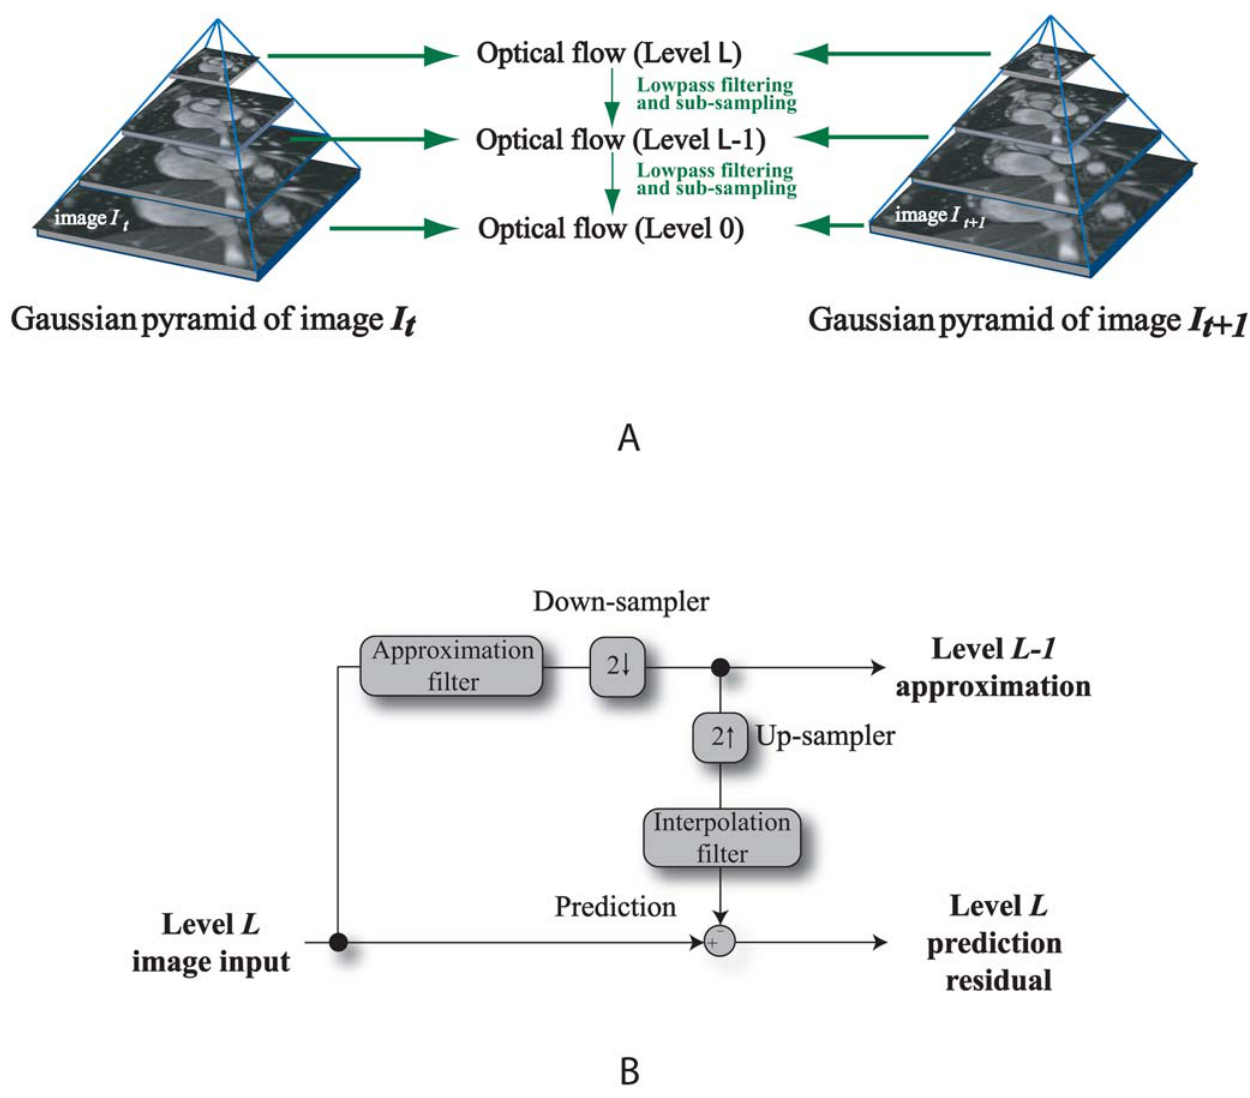
Figure 9. Multi-resolution motion estimation using pyramid implementation. Diagrammatic view of the Gaussian pyramid with optical flow applied onto every image level (0 to L ) is presented in subfigure A. Each level in the pyramid is a sub-sampled version of the level below. In the first step, the optical flow between the top level images is computed. We project the computed coarse-level flow field onto the next finer pyramid level and continue this at each level of the pyramid until the finest pyramid level has been reached. The system block diagram in subfigure B gives an illustration of the algorithmic operation of this pyramidal implementation.